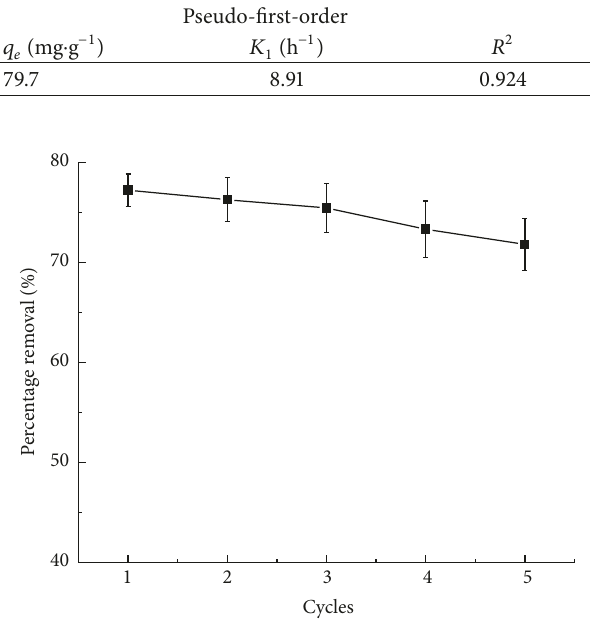
Figure 11: The adsorption capacity after desorption using hybrid membrane of carboxymethyl chitosan and silicon dioxide for